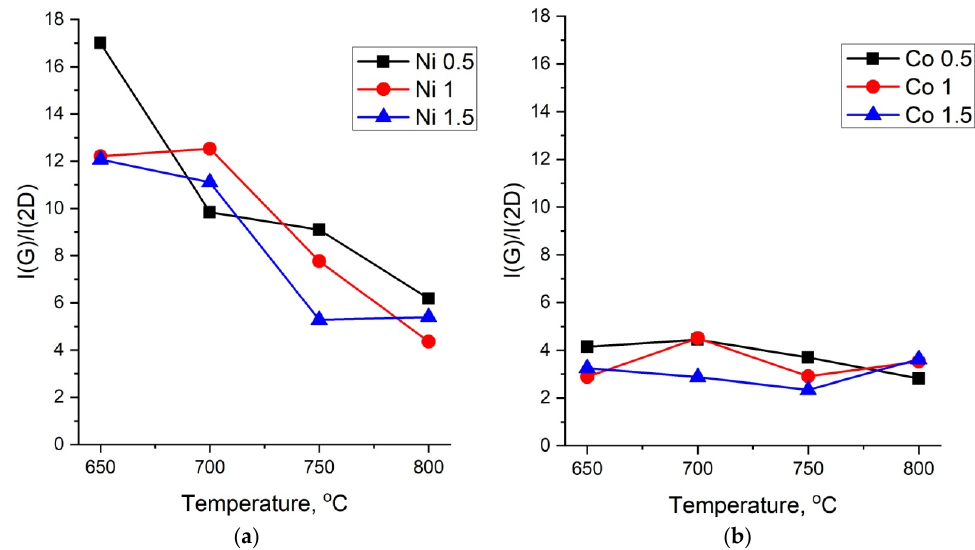
Figure 8. Dependences of the ratio of intensities I(G)/I(2D) on the synthesis temperature of MWCNTs. ( a ) Ni and ( b ) Co